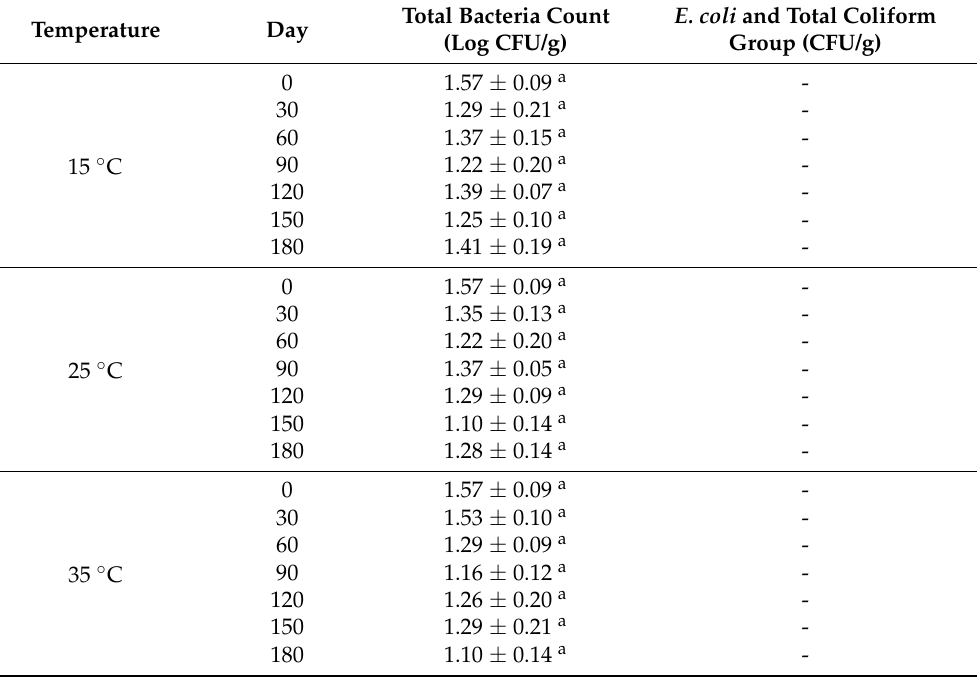
Values are mean ± SD. The small letter (a) in a column indicates the significant difference among means by the Tukey’s test ( p < 0.05). Dash (-) indicates not